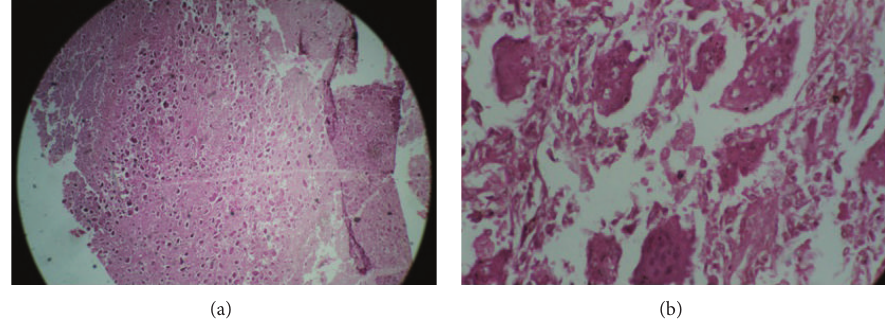
Figure 4: Histopathological slides showing giant cells suggestive of osteoclastoma.